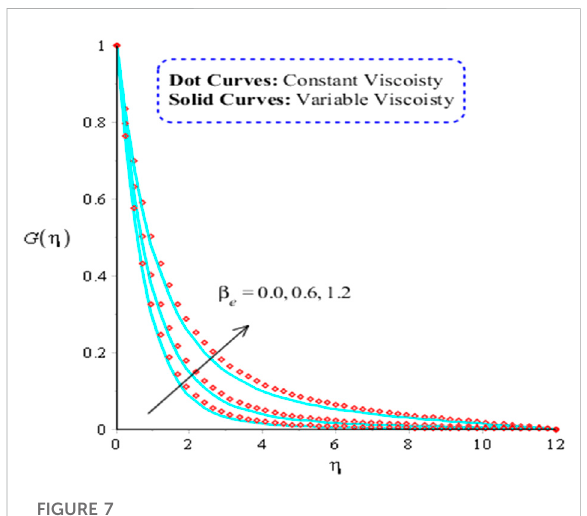
FIGURE 9 Variation in secondary velocity fi eld versus Θ γ